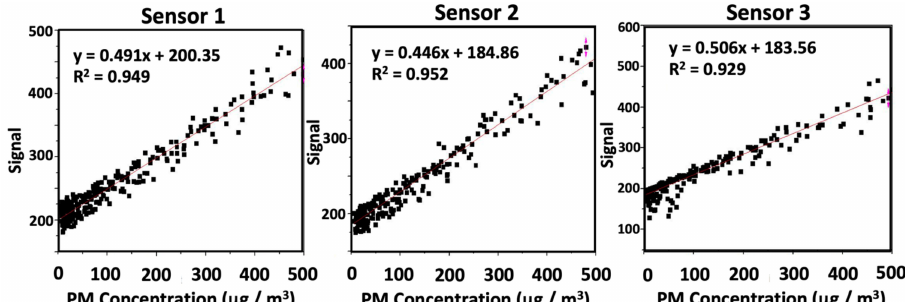
Figure 3. Calibration plots for sensors 1–3. Observed signal from the Sharp GP2Y1010AU0 dust sensors vs. PM concentration indicated by the RAM reference method for laboratory generated polydisperse NaCl aerosol. Observed signal is the digital count assigned by the Arduino board during analog-to-digital conversion. Di ff erences were found in slope and intercept between the sensors tested, and R 2 > 0.92 observed. Relative humidity within the 3.6 m 3 chamber during calibration was <